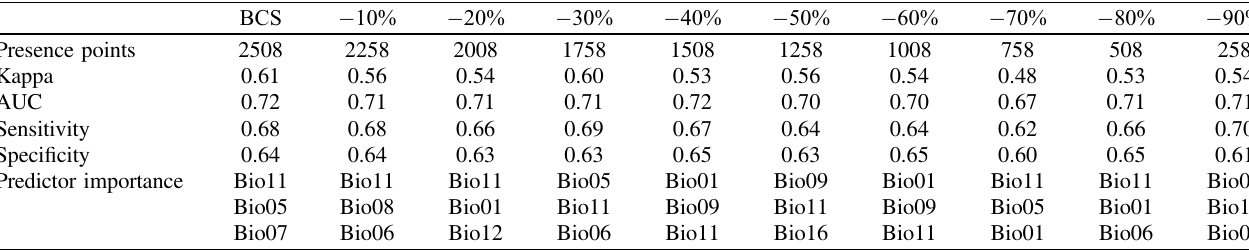
Table 2. Statistical model output baseline model using RF of Dicrocoelium dendriticum